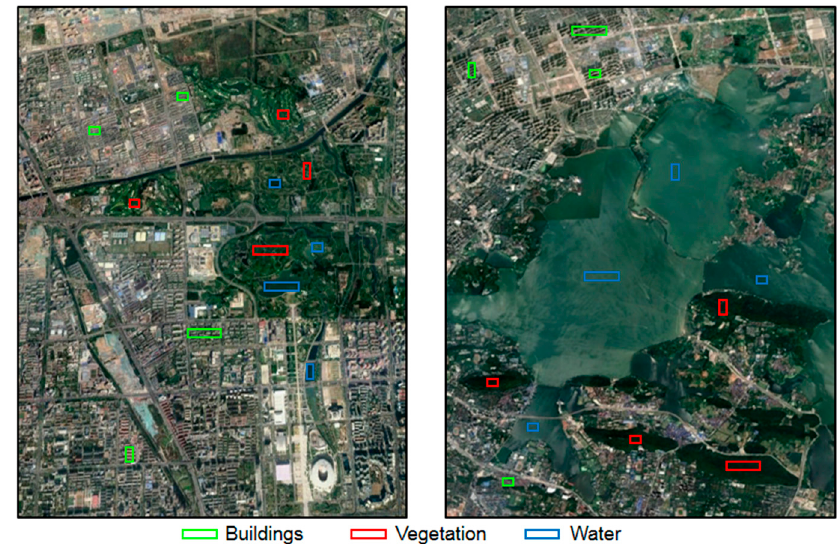
Figure 2. Google Earth images of the study areas in Beijing (left) and in Wuhan (right).